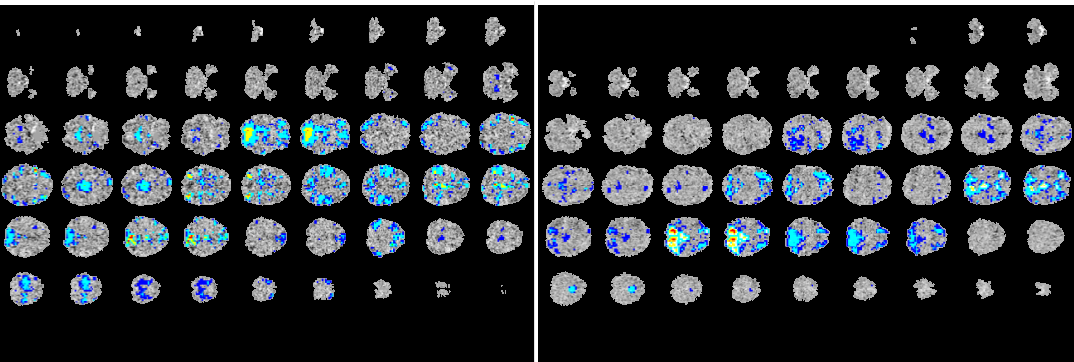
Figure 3. Explanations of model predictions. Cross-sections of fMRI scans indicating the regions that the network focused on when making predictions. Left: scans from a patient with autism; right: scans from a healthy individual with normal development. These images depict the regions the model used to predict the diagnosis of the scan, offering transparency on the model’s decision-making